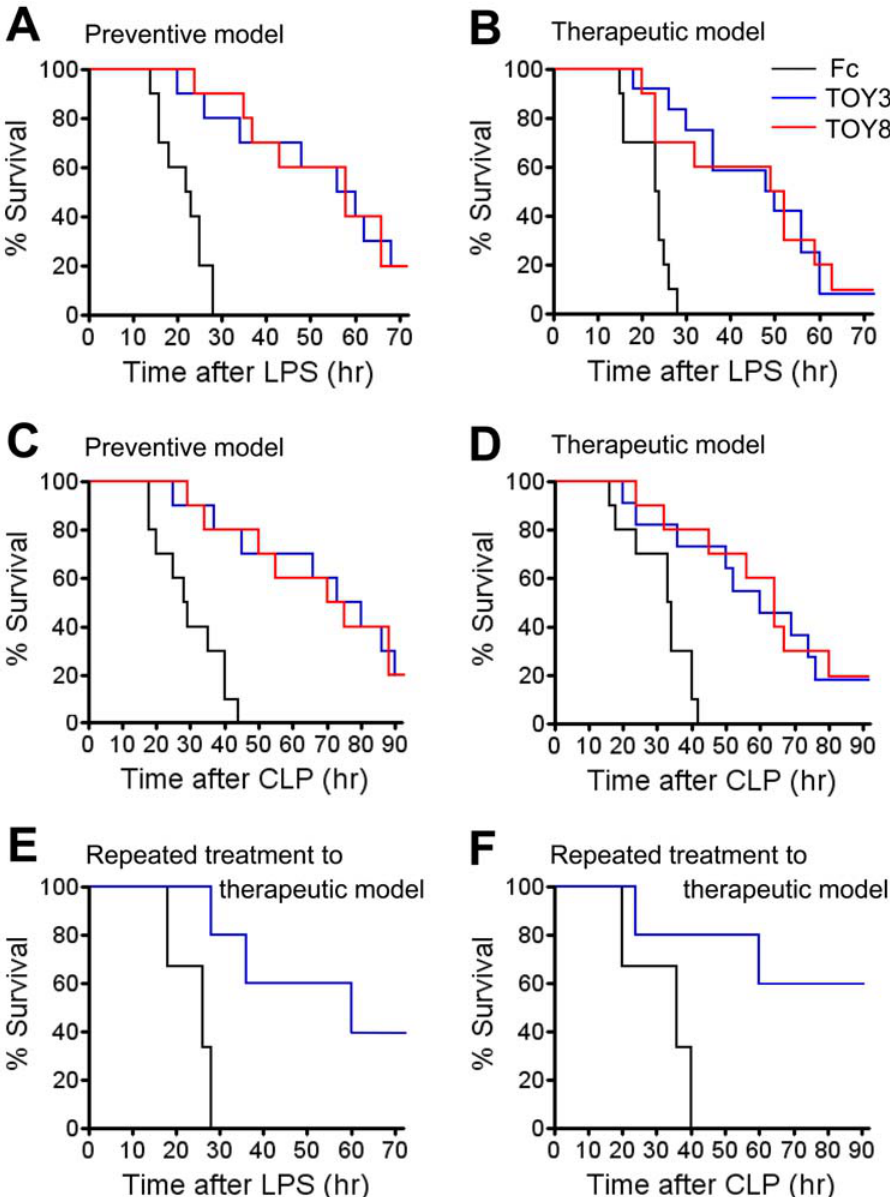
Figure 6. TOY attenuates lethality in two sepsis mouse models and is effective in both prophylactic and therapeutic treatments. ( A–D ) 20 mg/kg of Fc, TOY3, or TOY8 was given intraperitoneally to mice 30 min before ( A ) or 1 hr after ( B ) intraperitoneal administration of LPS (15 mg/kg). The protein is given 1 hr before ( C ) or 1 hr after ( D ) generation of CLP. ( E and F ) 20 mg/kg of Fc or TOY3 was given intraperitoneally to the mice at 1 hr and 12 hr after intraperitoneal administration of LPS (15 mg/kg) ( E ) or at 1 hr and 12 hr after generation of CLP ( F ). % Survival represents remaining live mice from total mice ( n =10–11).